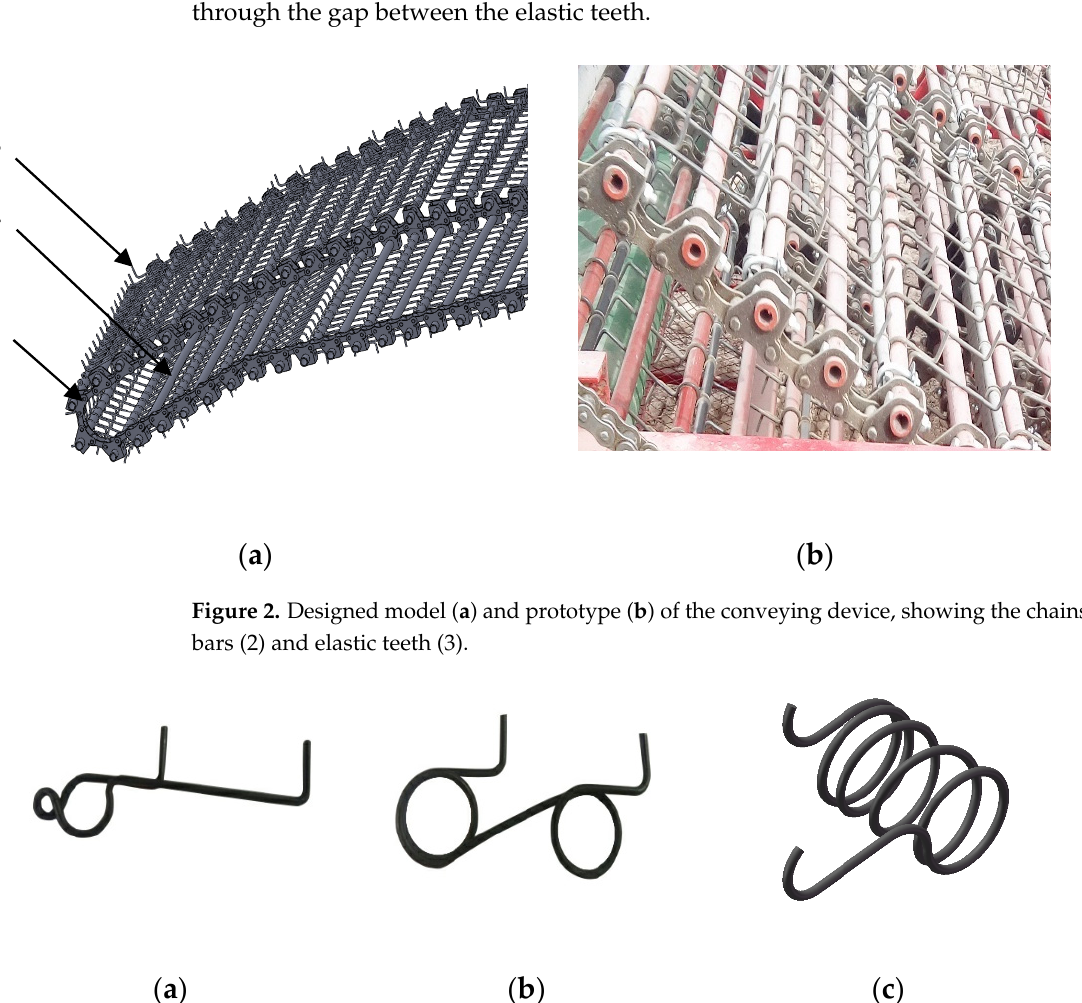
Figure 3. Designs of three types of elastic teeth, A, B and C, as shown in Figure ( a – c ). The mechanism for separating residual PF from soil and impurities was composed of a conveyer belt, supporting roller and roller chain system, and the rotating direction of the conveyer belt was counterclockwise. The separation of residual PF from soil and impurities was realized by the difference in the falling velocity of residual PF and soil particles and impurities on the belt. The PF recycling box, installed at the rear and lower position of the conveyor chain, was a rectangular screen box with dimensions of 500 mm × 1500 mm. After the separation of PF debris entering into the rectangular screen box, the smaller size of impure particles fell to the surface through the screen